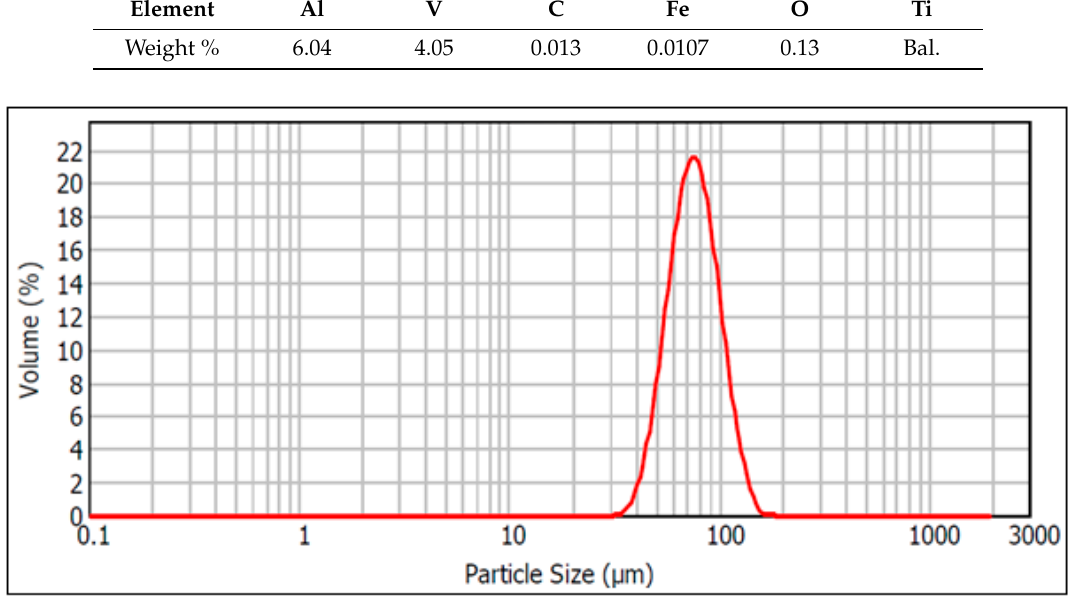
Figure 3. Measured powder particle size distribution.